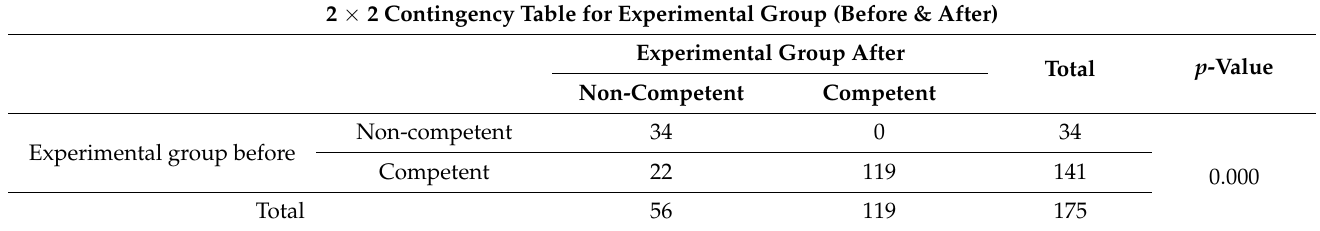
Table 2. McNemar test analysis for competent and non-competent in the experimental